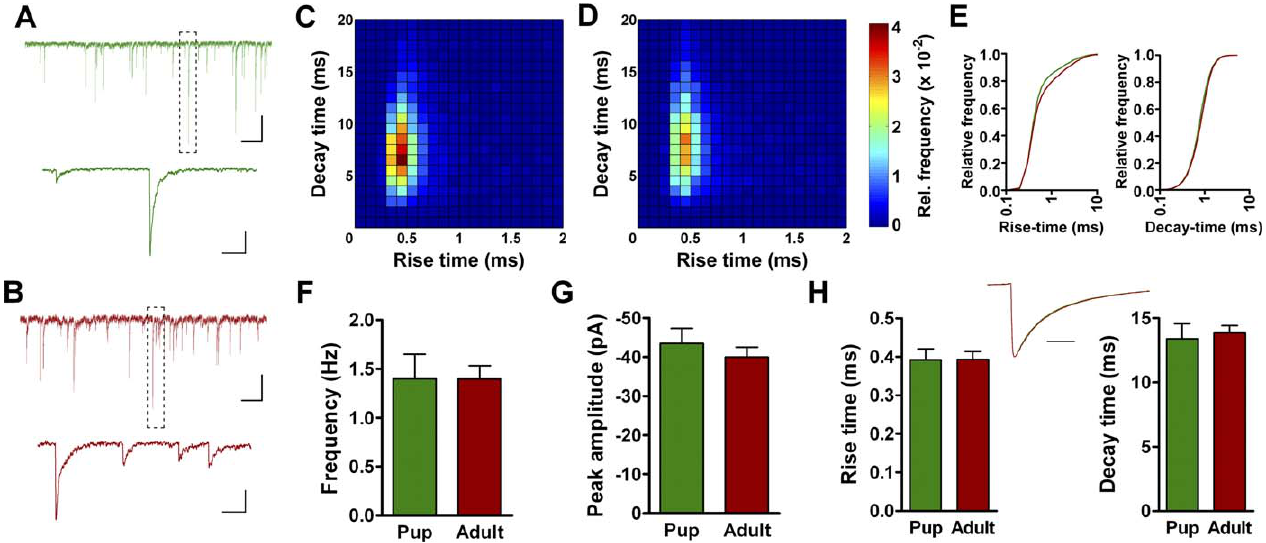
Figure 6. Fast-Perisomatic sIPSCs (A) and (B) Example of traces of inward sIPSCs recorded from a pup (A) and adult (B) DGC. Dashed box on each top trace denotes expanded segment on the bottom. Scale bars indicate 1 s/50 ms (top/bottom), 40 pA. (C) and (D) Two-dimensional histograms of rise and decay time of individual sIPSCs recorded from pup ([C] n ¼ 5,871 events) and adult DGCs ([D] n ¼ 8,183 events). Color scale indicates the relative frequency for each bin (square areas in the graph). (E) Cumulative histograms of rise and decay time of all sIPSCs recorded from pup (green) and adult (red) DGCs. Data are the same as shown in (C) and (D). (F) Frequency of sIPSCs (pup, n ¼ 12 neurons; adult, n ¼ 15; p ¼ 0.99; t -test). (G) Peak amplitude of sIPSCs ( n , same as in [F]; p ¼ 0.44). (H) Kinetics of sIPSCs. Inset: scaled averages of sIPSCs (pup, green; adult, red). Scale bar indicates 10 ms. All experiments conducted in the presence of kyn at V hold ¼(cid:2) 80 mV with an internal solution containing high [Cl (cid:2) ]. ( n , same as in [F]; rise time, p ¼ 0.96; decay time, p ¼ 0.72). DOI: 10.1371/journal.pbio.0040409.g006